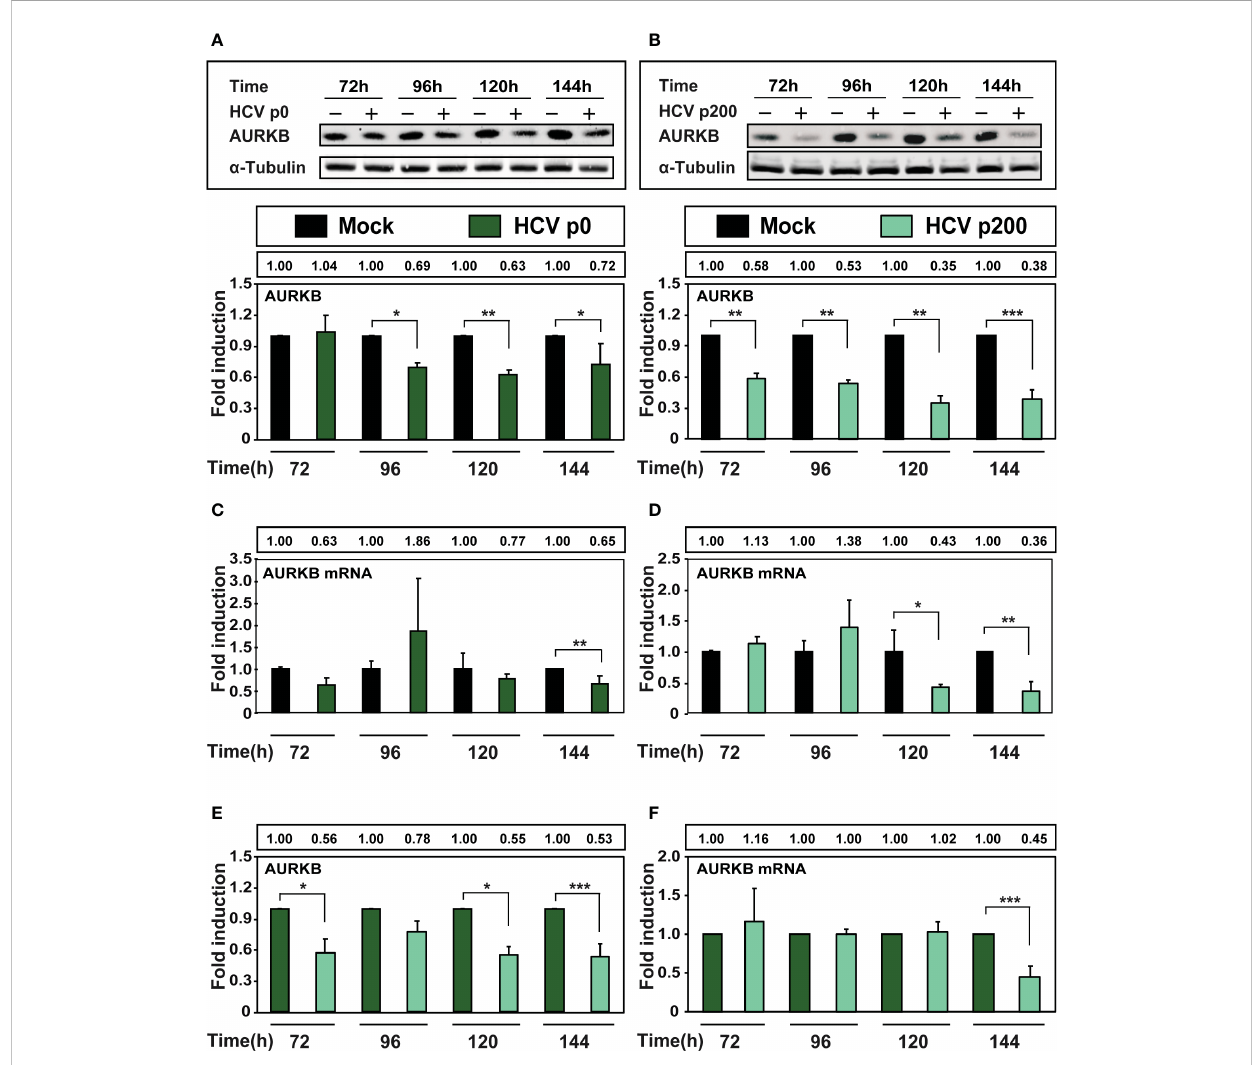
FIGURE 4 Effect of HCV infection on AURKB expression. Huh-7.5 reporter cells were either mock-infected or infected with HCV p0 and HCV p200 at a MOI of 0.03 TCID 50 /cell. (A) Western blot with extracts of cells infected with HCV p0. Bands correspond to the cellular AURKB and a -tubulin used as loading control. The lower panel shows the densitometry quanti fi cation of the bands, taking as reference the corresponding value for mock-infected cells, numerical values are given in the box above the lower panel. Times post-infection are indicated in abscissa. (B) Same as A but for HCV p200- infected cells. (C, D) RT-qPCR measurements of AURKB mRNA using GADPH gene as control. (E, F) Same as A-D but with the AURKB and AURKB mRNA levels in HCV-infected cells expressed as the fold induction relative to the corresponding value for the HCV p0 infected cells. Results are the average of three independent experiments (biological triplicate). Asterisks indicate statistical signi fi cance as follows: *p<0.05; **p<0.01; ***p<0.001; unpaired